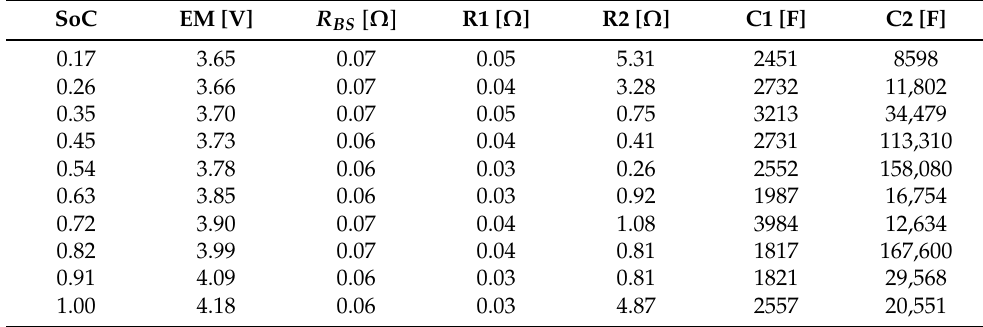
Table A1. Look-up table for the battery